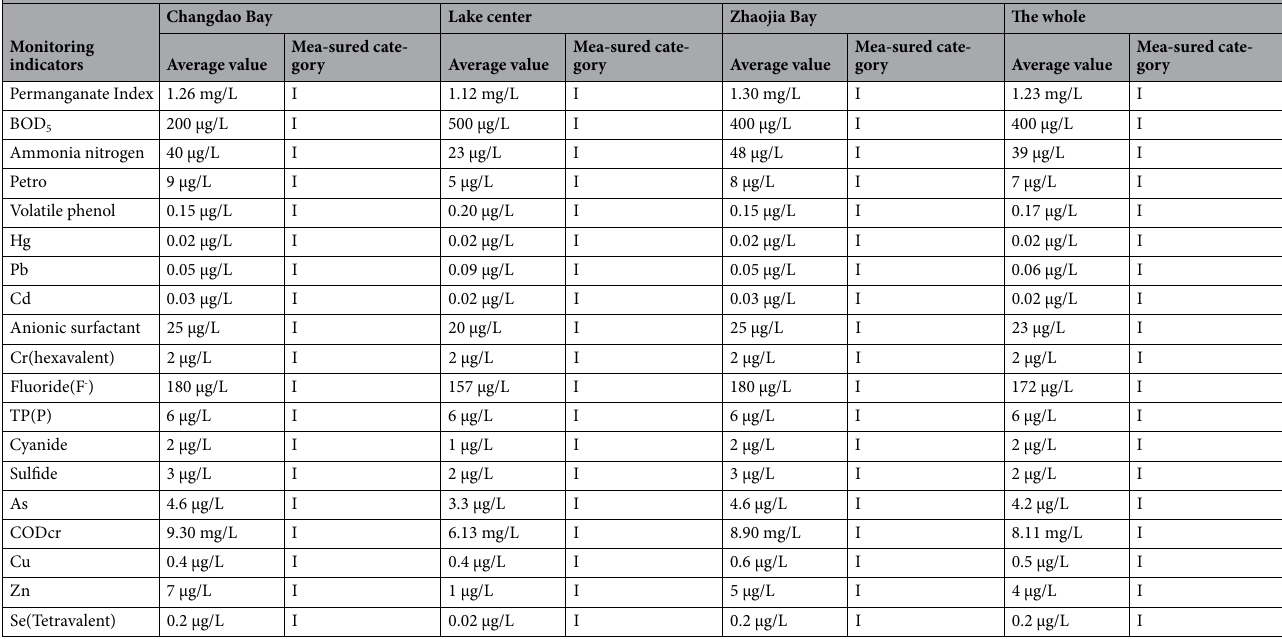
Table 4. Statistical results of various indicators in Lugu Lake in 2020.